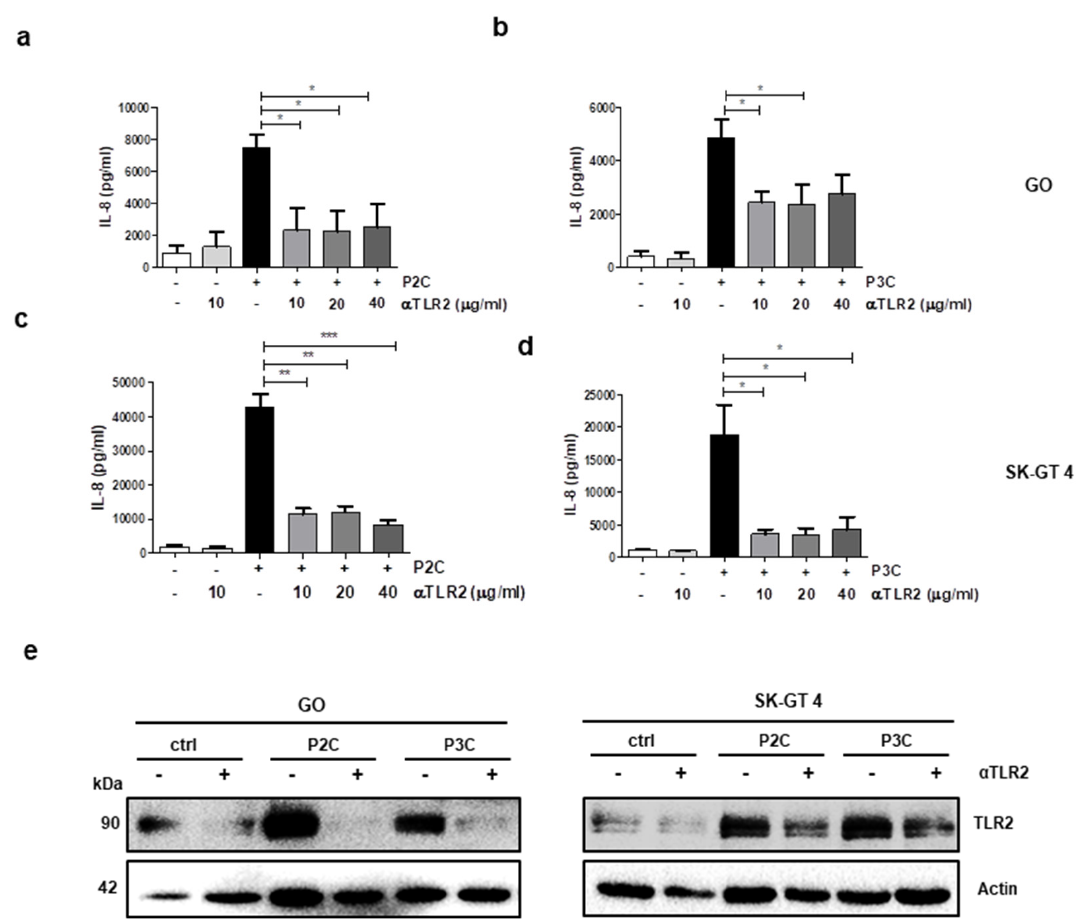
Figure 2. A TLR2 neutralising antibody limits TLR2-mediated IL-8 secretion and TLR2 upregulation in oesophageal cell lines. ( a , b ) GO and ( c , d ) SK-GT 4 cells were left untreated or pre-treated (1 h) with α TLR2 Ab (10 µg/mL; 20 µg/mL; 40 µg/mL) and subsequently stimulated with P3C (0.05 µg/mL) ( a , c ) or P2C (0.05 µg/mL) ( b , d ) for 24 h. Supernatants were analysed for IL-8 by ELISA. Data represent the mean ± SEM of n = 3; * p < 0.05; ** p < 0.01, *** p < 0.001 (unpaired two-tailed Student’s t -test). ( e ) TLR2 expression levels were analysed in untreated or α TLR2 (10 µg/mL) pre-treated (1 h) GO and SK-GT 4 cells, subsequently stimulated with TLR2 ligands, P3C or P2C (each at 0.05 µg/mL). Western blots are representative of three independent experiments.